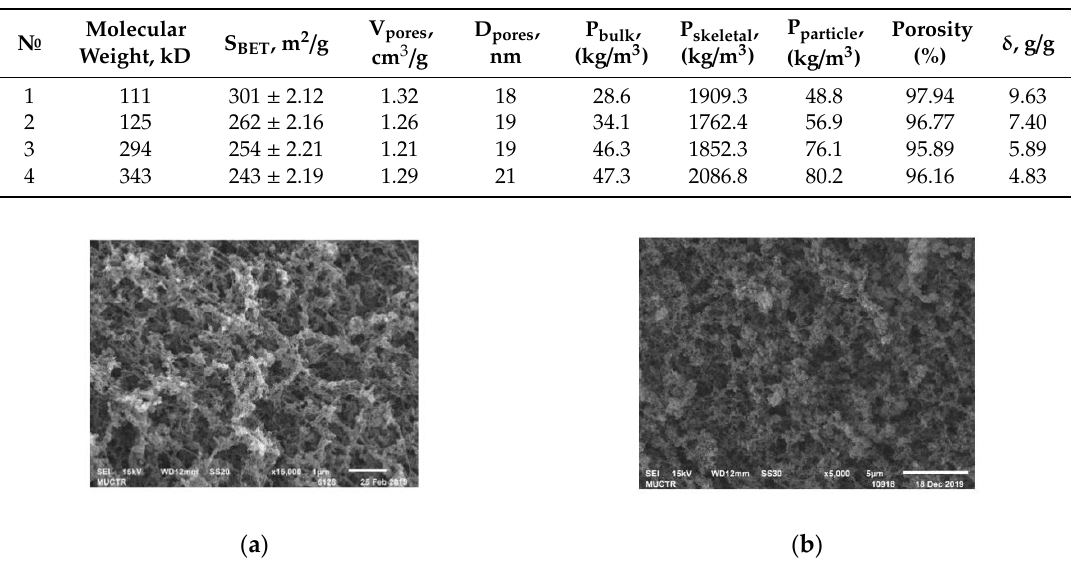
Figure 7. SEM images of the inner and outer surfaces of chitosan-based aerogel particles: ( a ) is the inner surface of the aerogel particle; ( b ) is the outer surface of the aerogel particle. Table 1. Results of the Analytical Experiments.